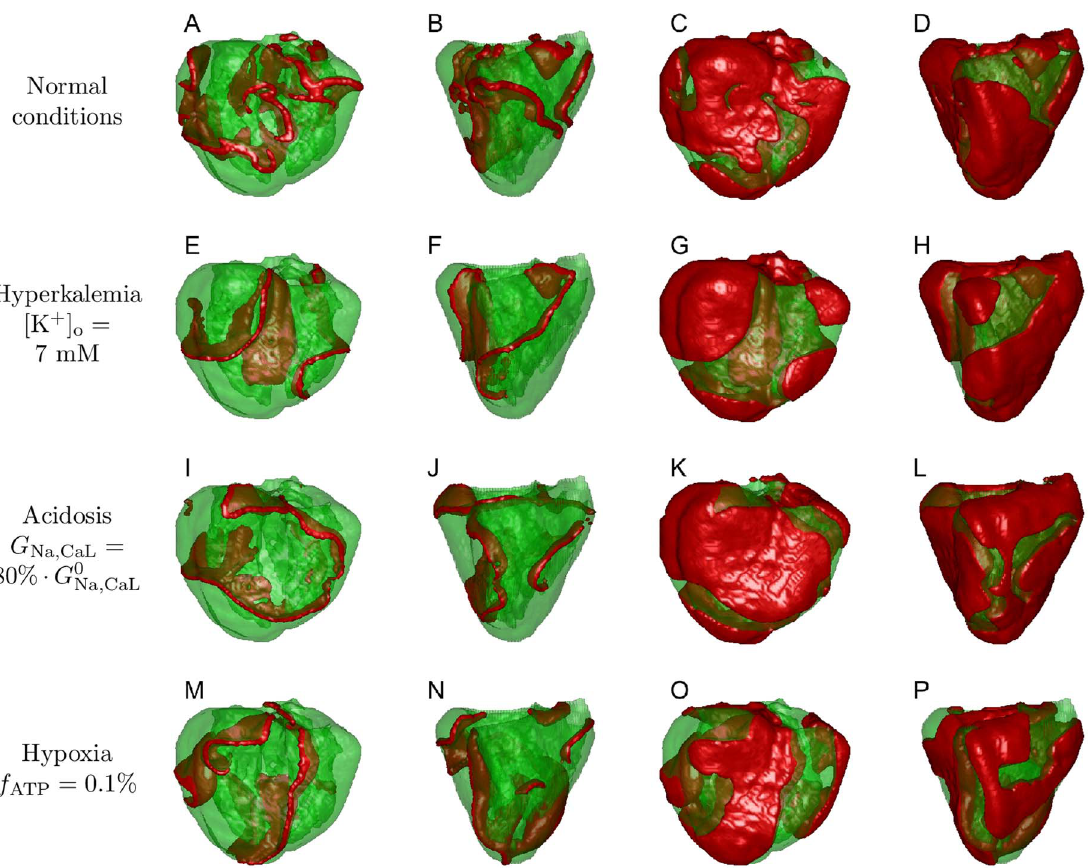
Figure 4. Fibrillation patterns. A–D: normal conditions, E–H: hyperkalemia, I–L: acidosis, M–P: hypoxia. In the first two columns the red color shows the location of wavefronts, and in the last two columns it shows exited tissue where the transmembrane voltage is higher than APD 90 level. Columns 1, 3 show the frontal view and columns 2, 4 show the lateral view.